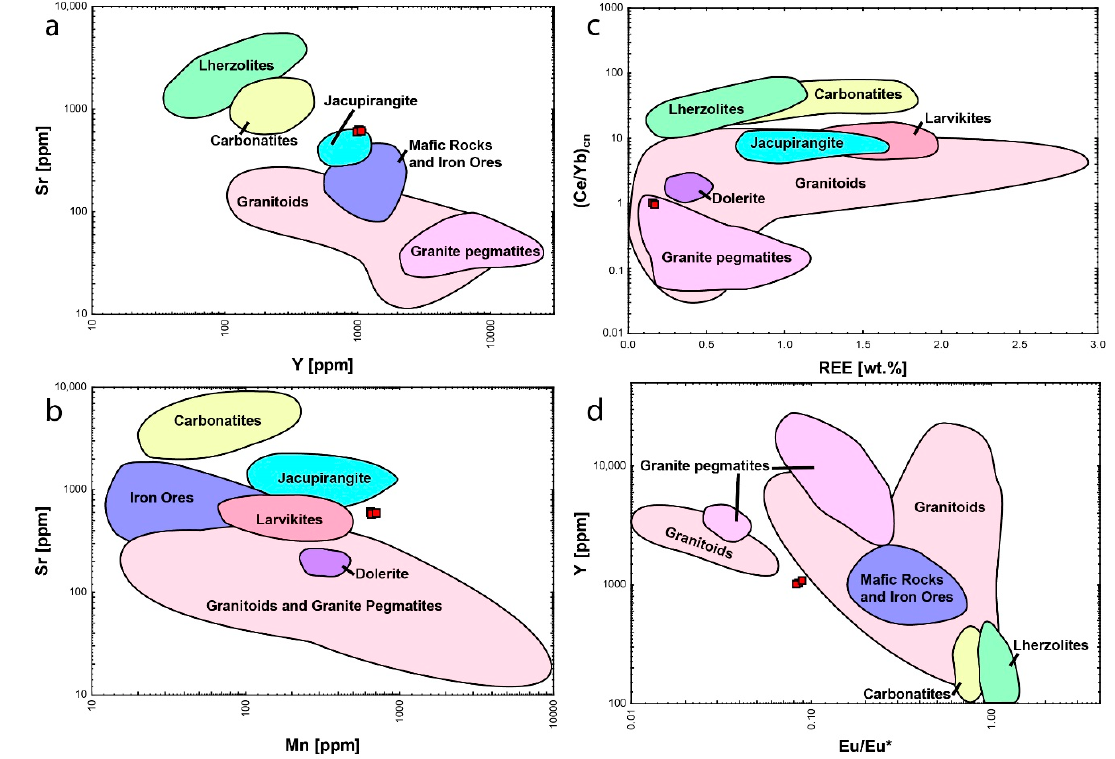
Figure 12. The Muránska Dlhá Lúka hydroxylapatite compositions (red squares) in plots of Sr versus Figure 12. The Mur á nska Dlh á L ú ka hydroxylapatite compositions (red squares) in plots of Sr versus ( a ) Y and ( b ) Mn, ( c ) (Ce/Yb)cn versus the sum of REE, and ( d ) Y against Eu/Eu* with fields of apatite ( a ) Y and ( b ) Mn, ( c ) (Ce / Yb)cn versus the sum of REE, and ( d ) Y against Eu / Eu* with fields of apatite compositions for selected rock types [1]. compositions for selected rock types